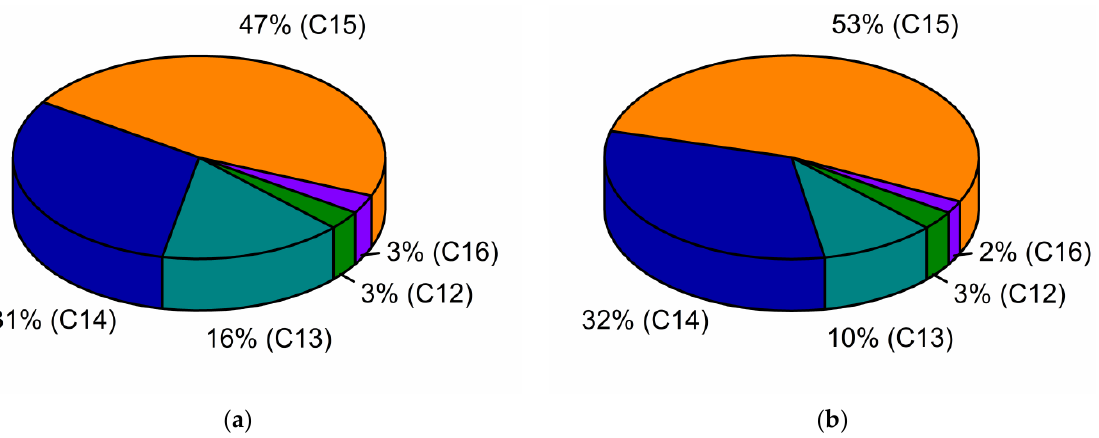
Figure 3. Effect of sunflower cake ( a ) and rapeseed cake ( b ) media on the production of surfactin homologues.